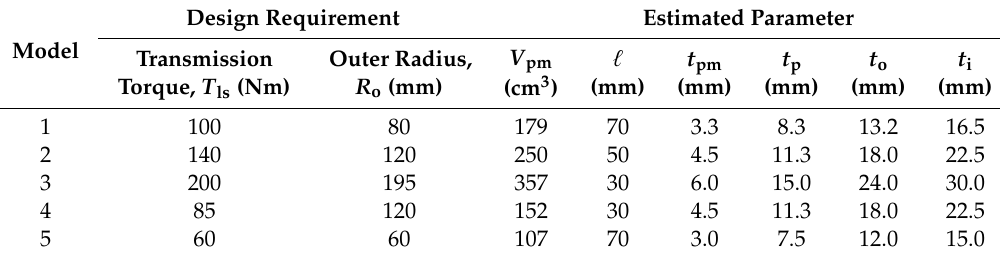
Table 2. The conditions and parameters for design verification of magnetic